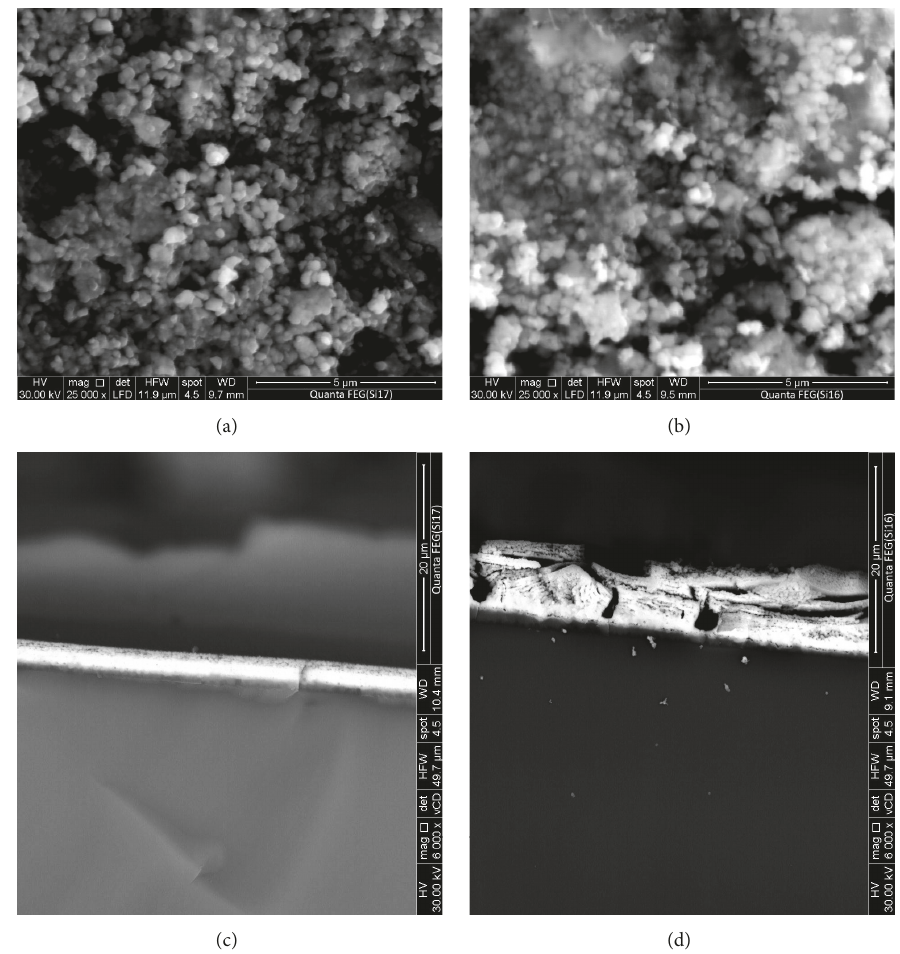
Figure 2: Top view of ZnO thin films S1 and S2 using